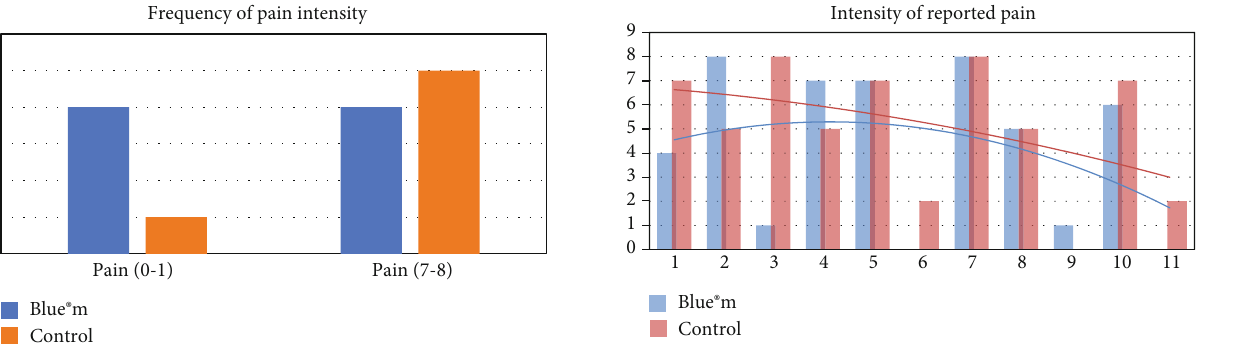
Figure 3: Frequency of pain by strati fi cation of pain intensity. Figure 4: Intensity of reported pain between the control and test sides. ANOVA, p = 0 : 0233